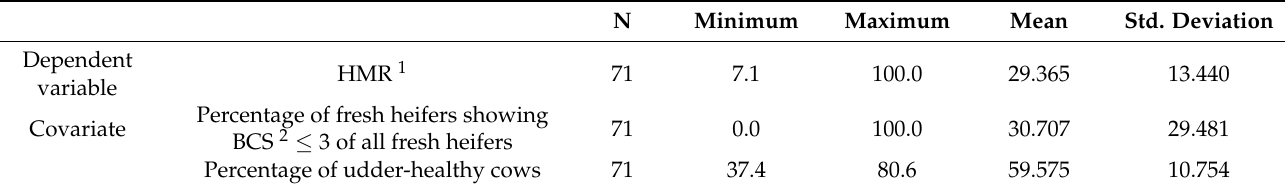
Table 4. Continuous variable information.